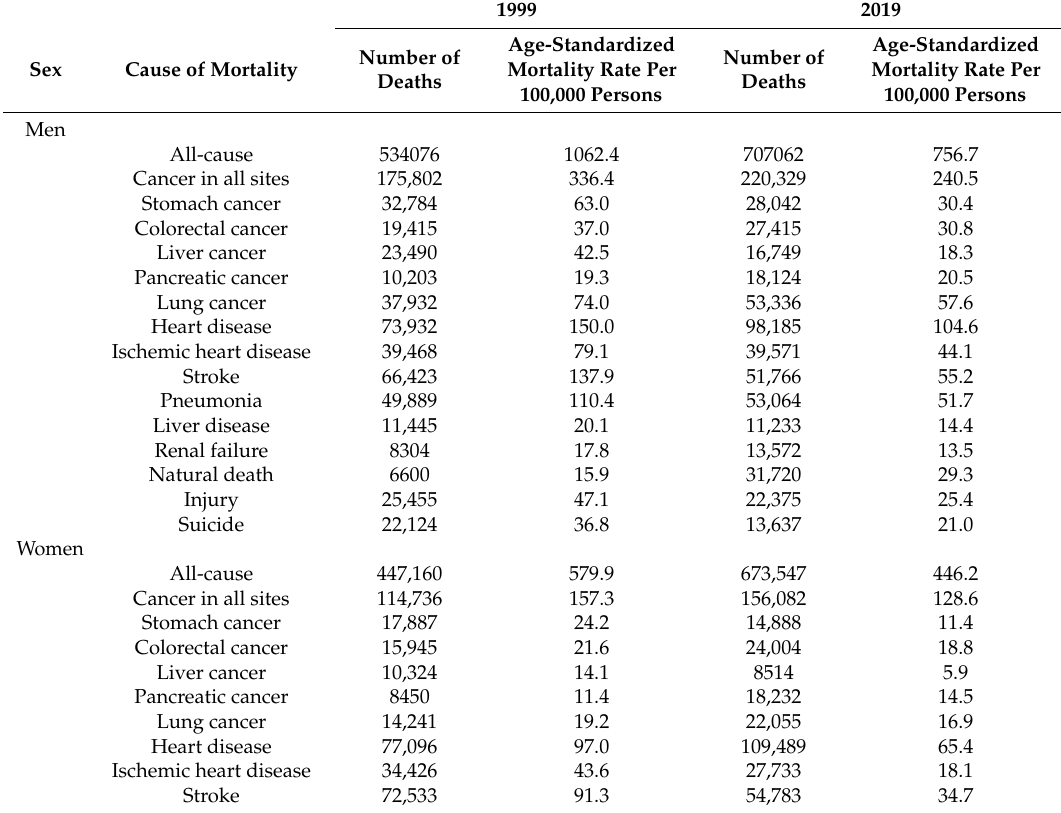
Table 2. Japan’s number of deaths and age-standardized mortality rates per 100,000 people for all-cause and each cause of mortality in 1999 and